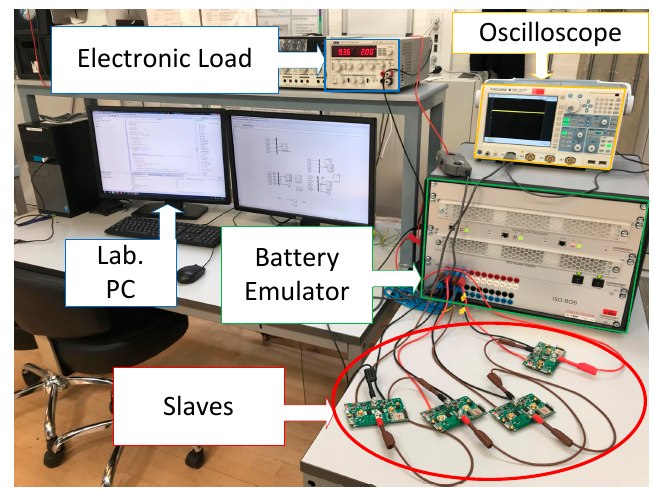
Figure 11. Down-scaled experimental prototype.